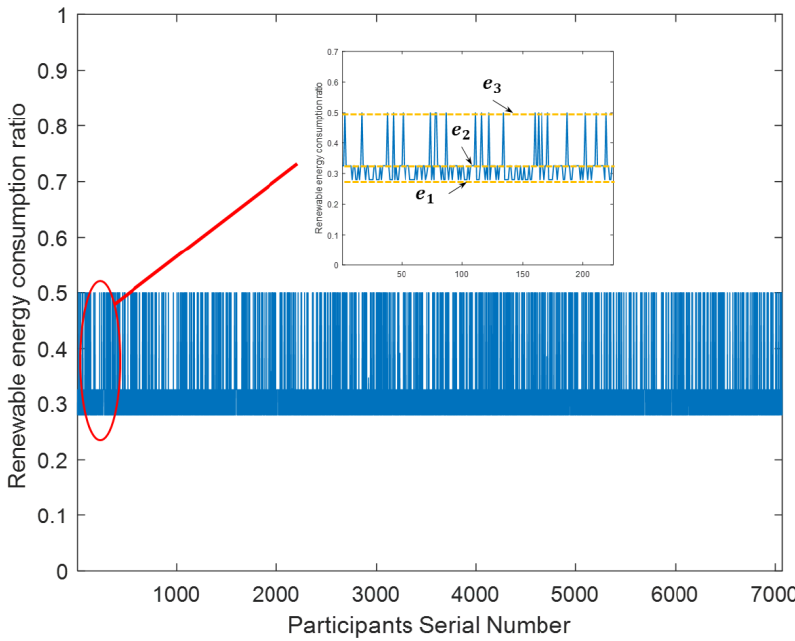
Figure 6. Optimal solution of renewable energy consumption weights for each market entity.